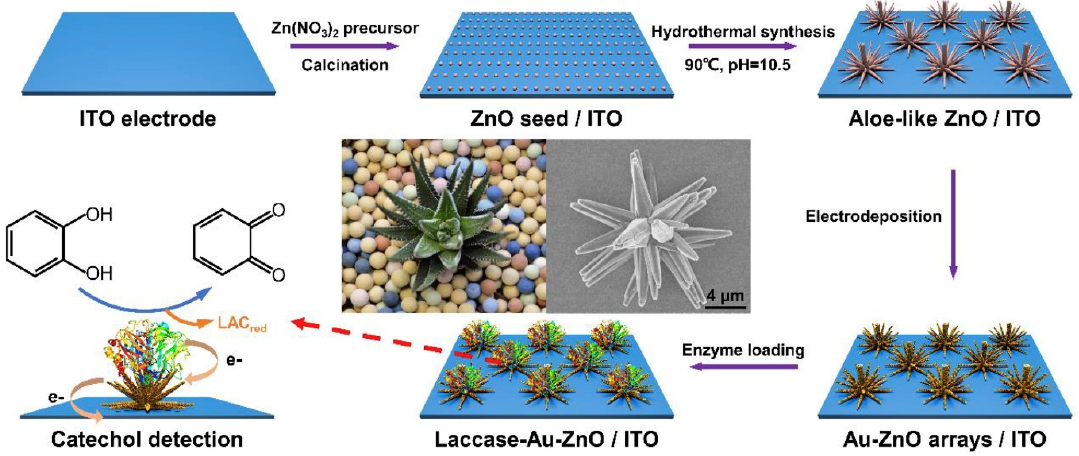
Figure 2. Schematic illustration of the preparation of aloe-like Au–ZnO arrays on an ITO electrode (reproduced from [49] with permission of Elsevier). (reproduced from [49] with permission of